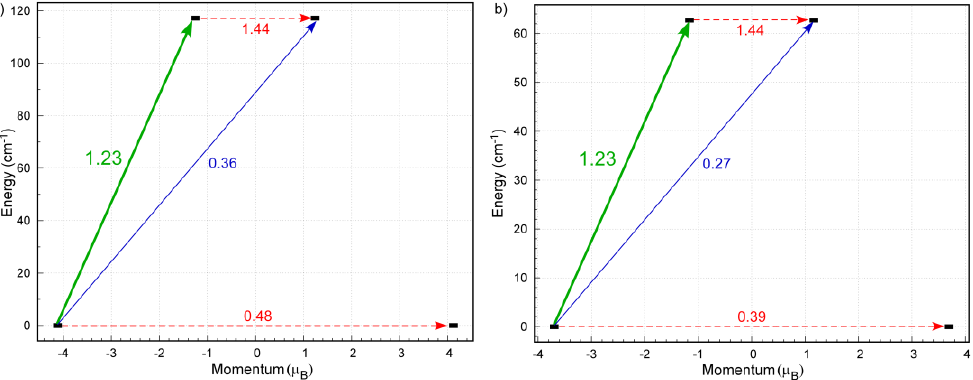
Figure 5. AILFT computed d-orbital splitting representation of the distorted ( a ) TPR; and ( b ) Td coordination environments.